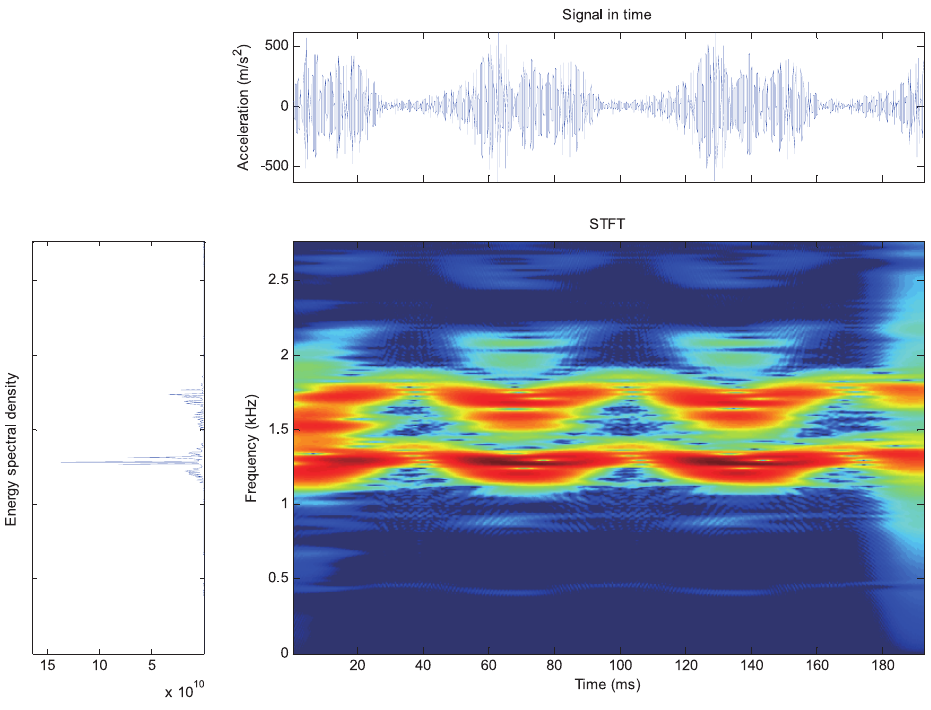
Fig. 12. STFT of the pinion bearing acceleration for a time varying applied